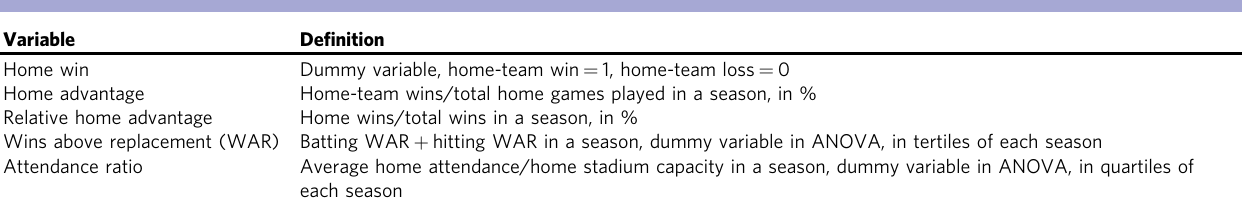
Table 1 De fi nitions of